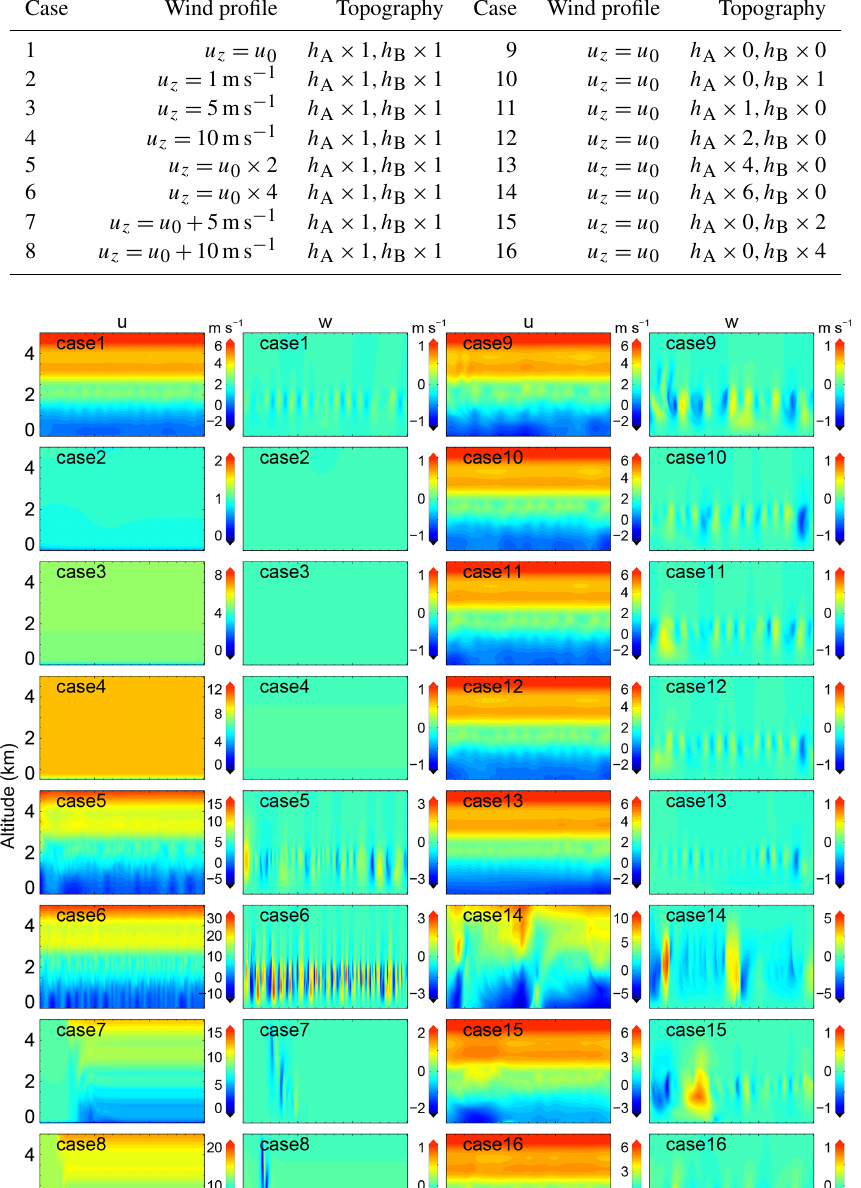
from 01:00 to 08:00, except with regard to the internal wave with a period of ∼ 6 min at 07:00. Fritts et al. (2003) reported wave motions with typical periods of 4–5 min below a height of ∼ 800 m under light wind with low-level jet and clear-sky conditions throughout the night of 14 October 1999. These wave motions were interpreted as ducted GWs that propa-